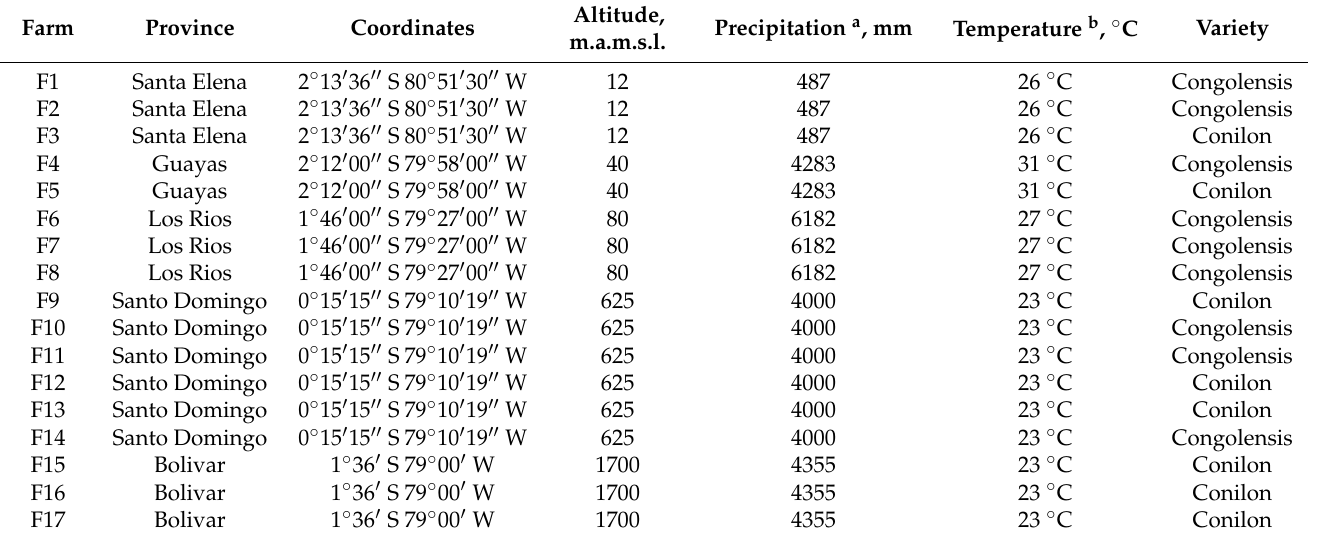
Table 1. Features of the 17 sampling coffee farms.